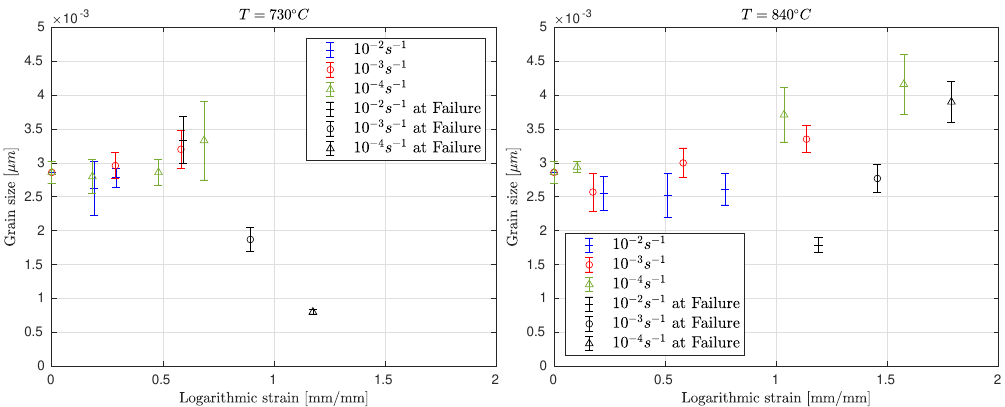
Figure 6. Grain size evolution at 730 ◦ C and 840 ◦ C for several strain rate conditions for several elongation levels and at the